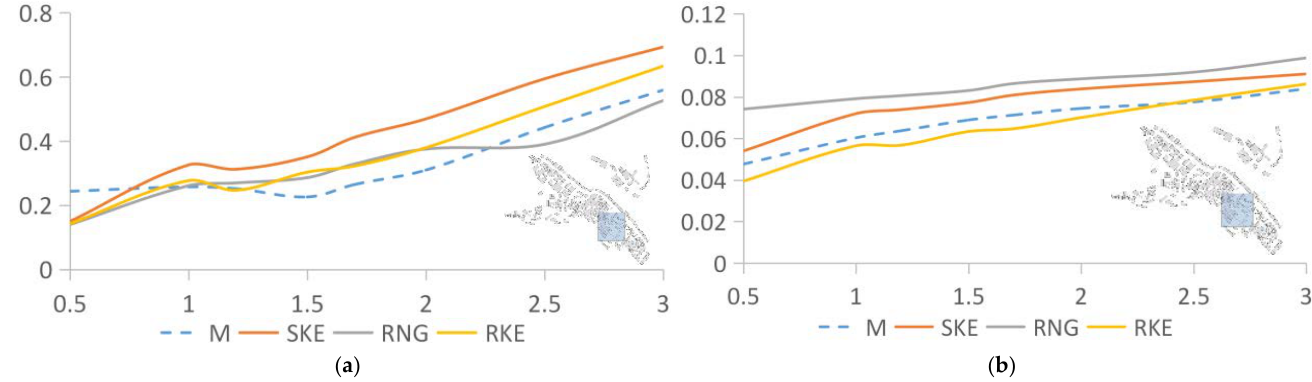
Figure 9. Analysis of the measured values and the values simulated by SKE, RNG, and RKE in an area with a building density of 24.77%. ( a ) Wind speed comparison between SKE, RNG, RKE, and measured data. ( b ) Comparison of turbulence intensity between SKE, RNG, RKE, and measured data.